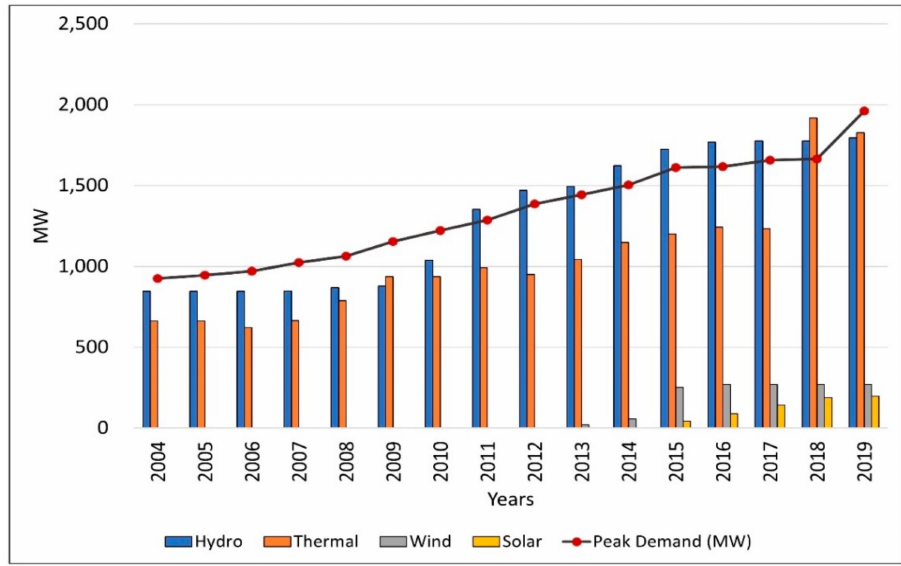
Figure 5. Peak demand growth of Panama by year from 2004 to